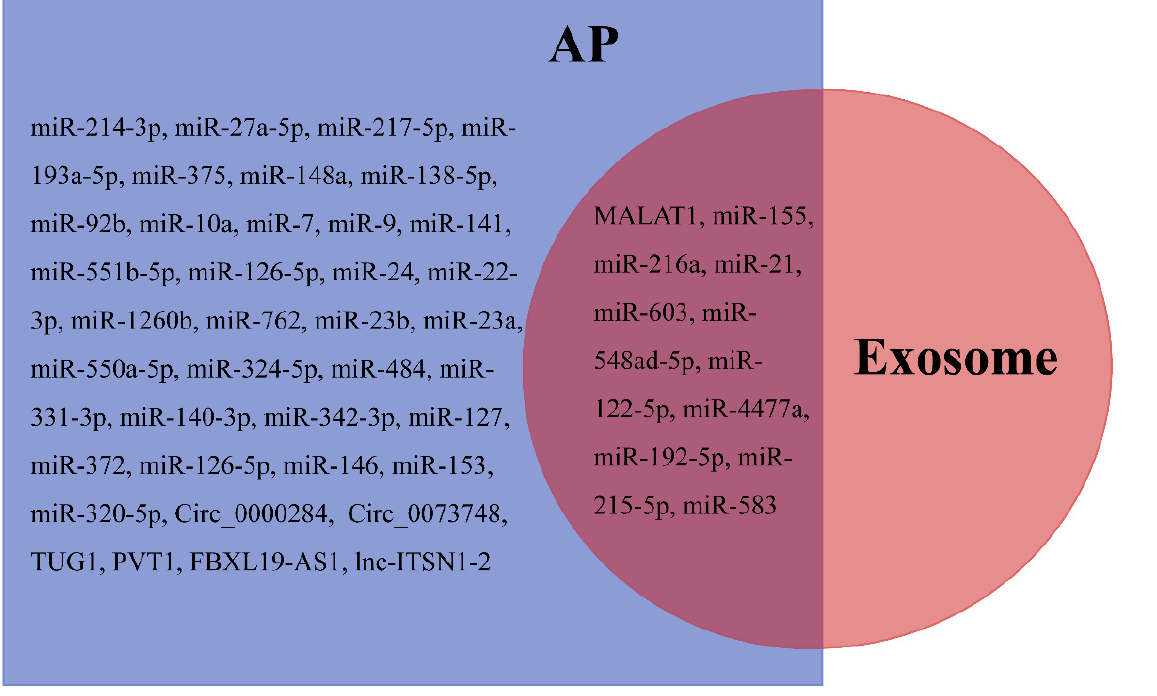
Figure 4. Differentially expressed non-coding RNAs in plasma/serum/mesenteric lymph/exosomes after AP.